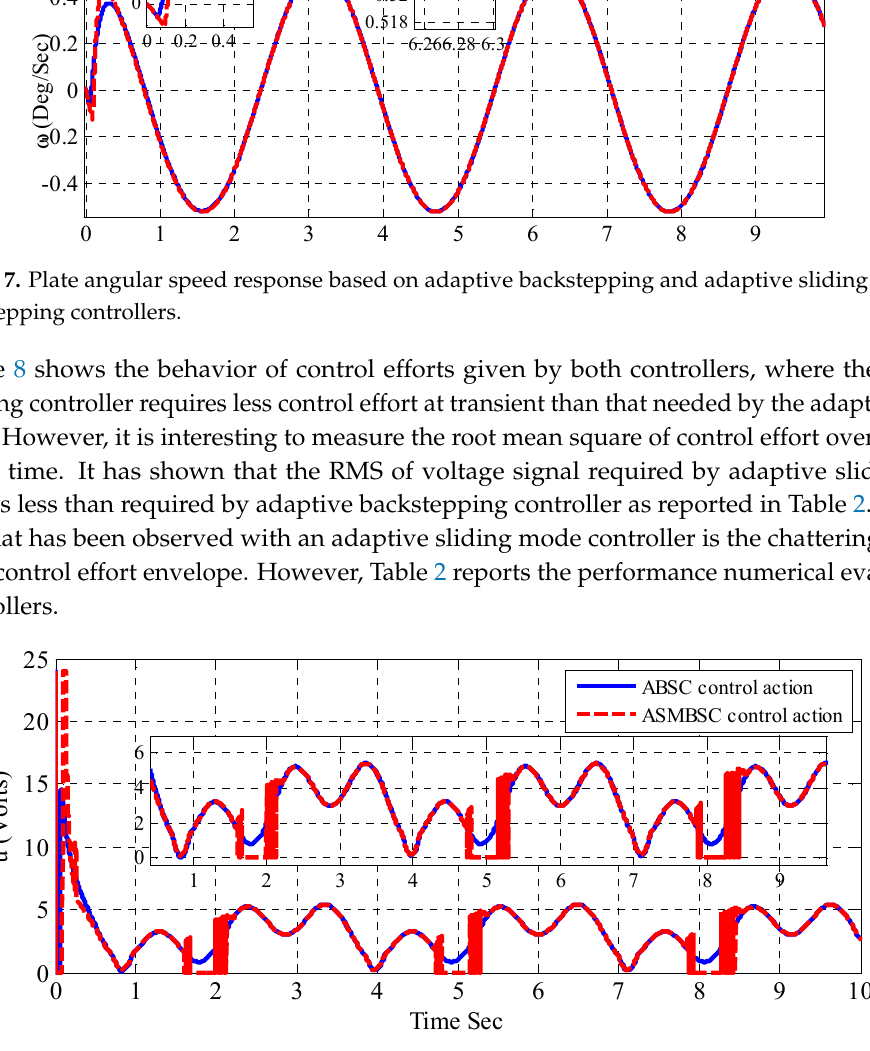
sliding mode backstepping controllers.